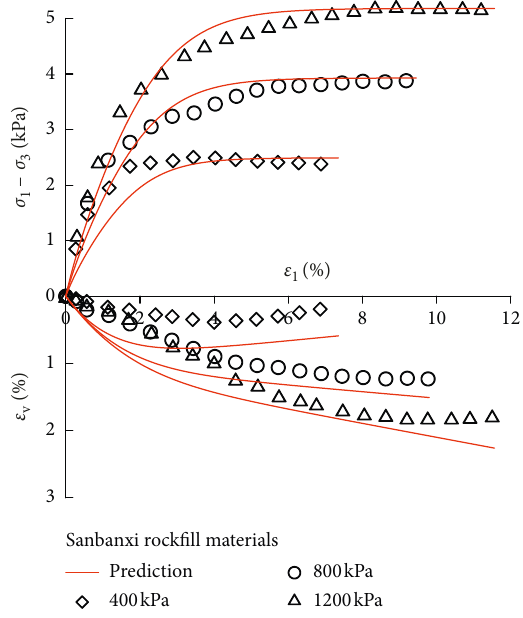
Figure 5: Sanbanxi rockfill materials experiment results and model